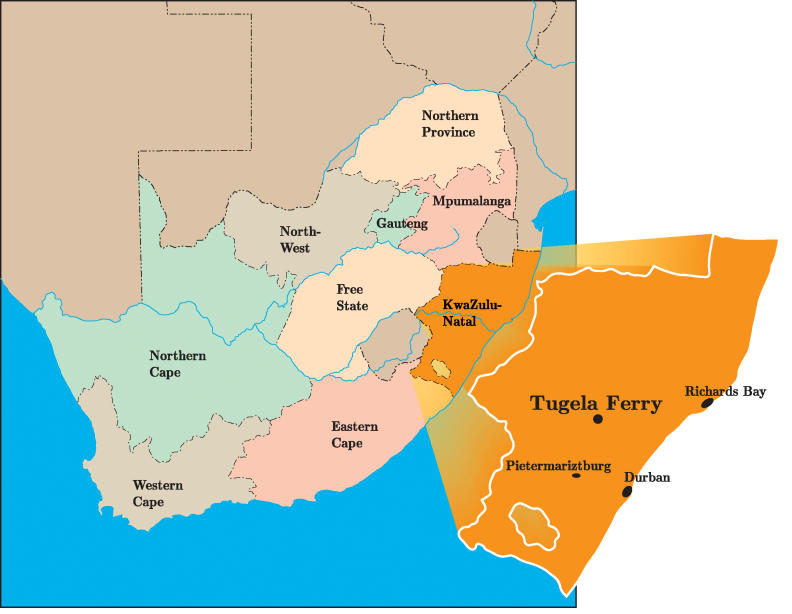
Map of South Africa Showing Tugela Ferry in the Province of KwaZulu-Natal, the Epicentre of South Africa's HIV/AIDS Epidemic